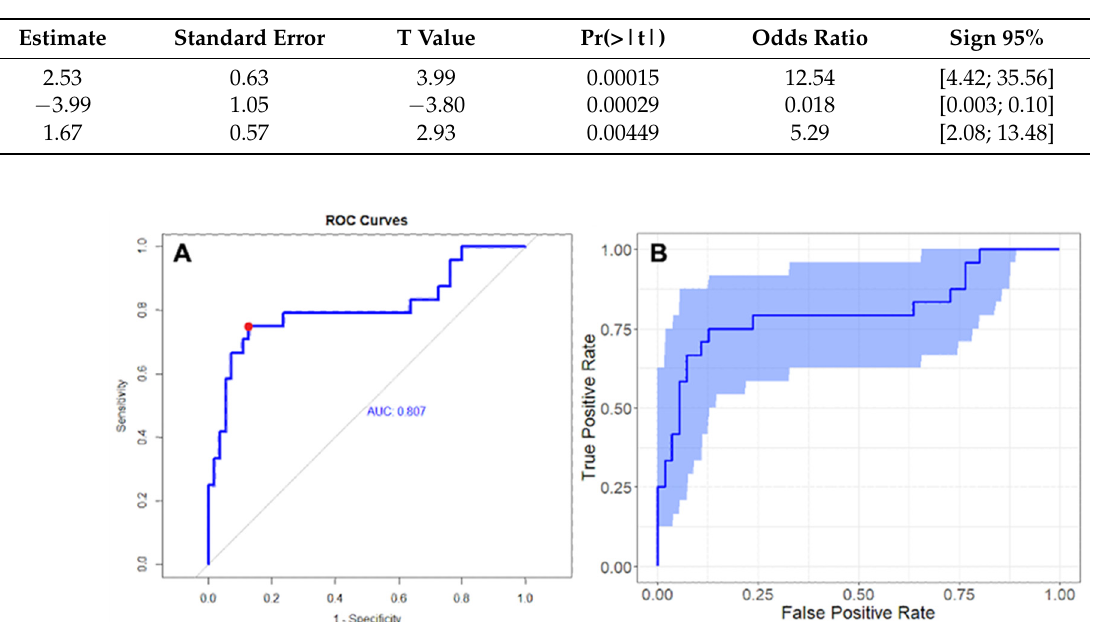
Figure 4. ROC curve of the best radiomic model in predicting the presence of liver metastases (AUC 0.807; specificity 0.87; sensitivity 0.75) ( A ) and result of Bootstrap simulation obtained with 1000 replications (95% CI 0.686–0.920) ( B ).